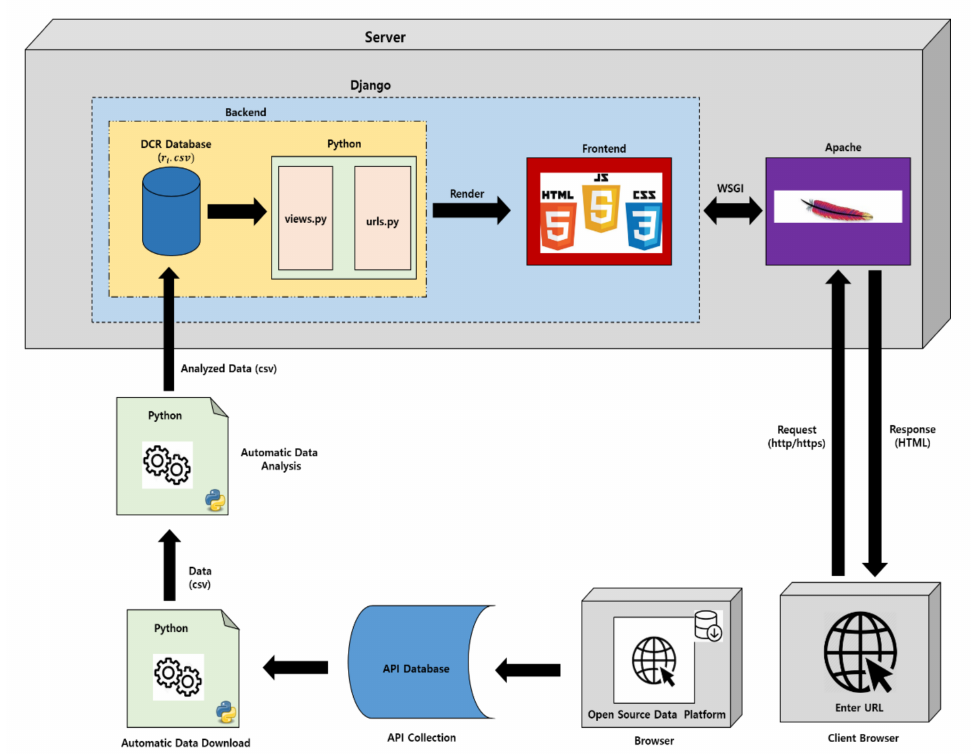
Figure 3. A Django-based framework to check the DCR of standard data available in the OGDP of South Korea.